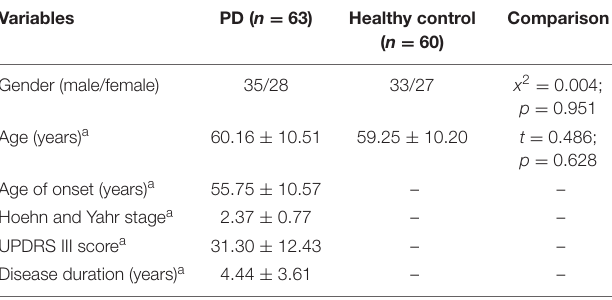
TABLE 2 | Demographic and clinical characteristics of PD group and healthy